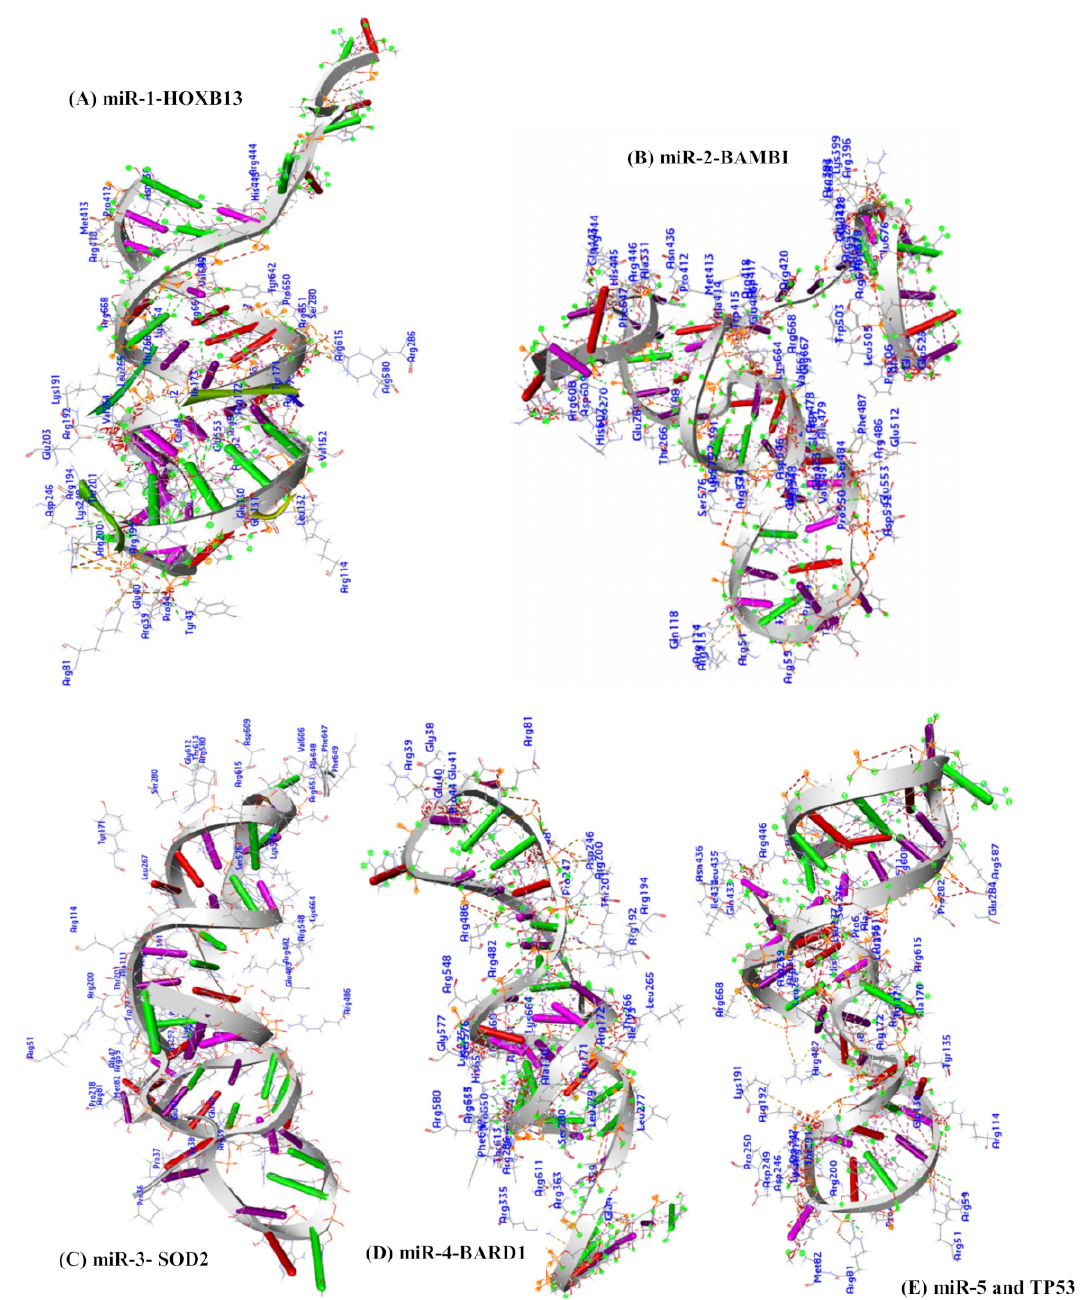
Figure 9. Docking complex results of microRNA-mRNA and the receptor (Chain A of argonaute protein). The amino acid residues participating in the interaction between the receptor and miR-1-HOXB13 ( A ); Residual amino acids participating in the interaction between the receptor and miR-2-BAMBI ( B ); miR-3-SOD2 ( C ); miR-4-BARD1( D ); and miR-5- TP53 ( E